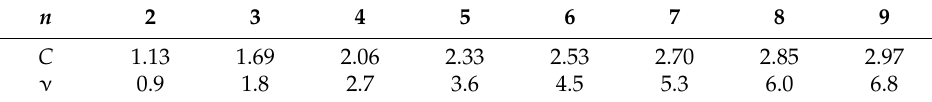
Table 3. Extreme difference coefficients and degrees of freedom